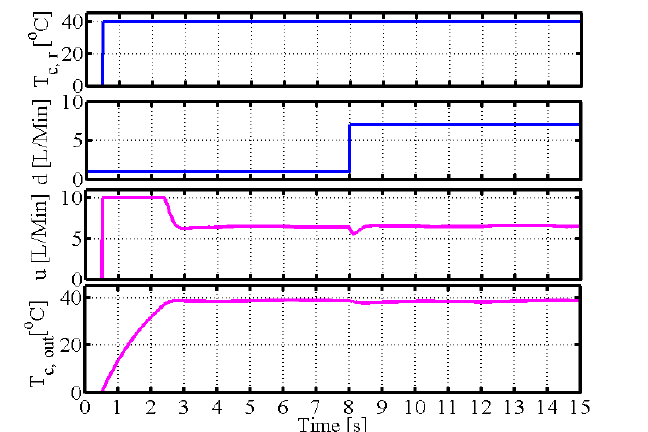
Figure 15. Simulation of PID with operator.